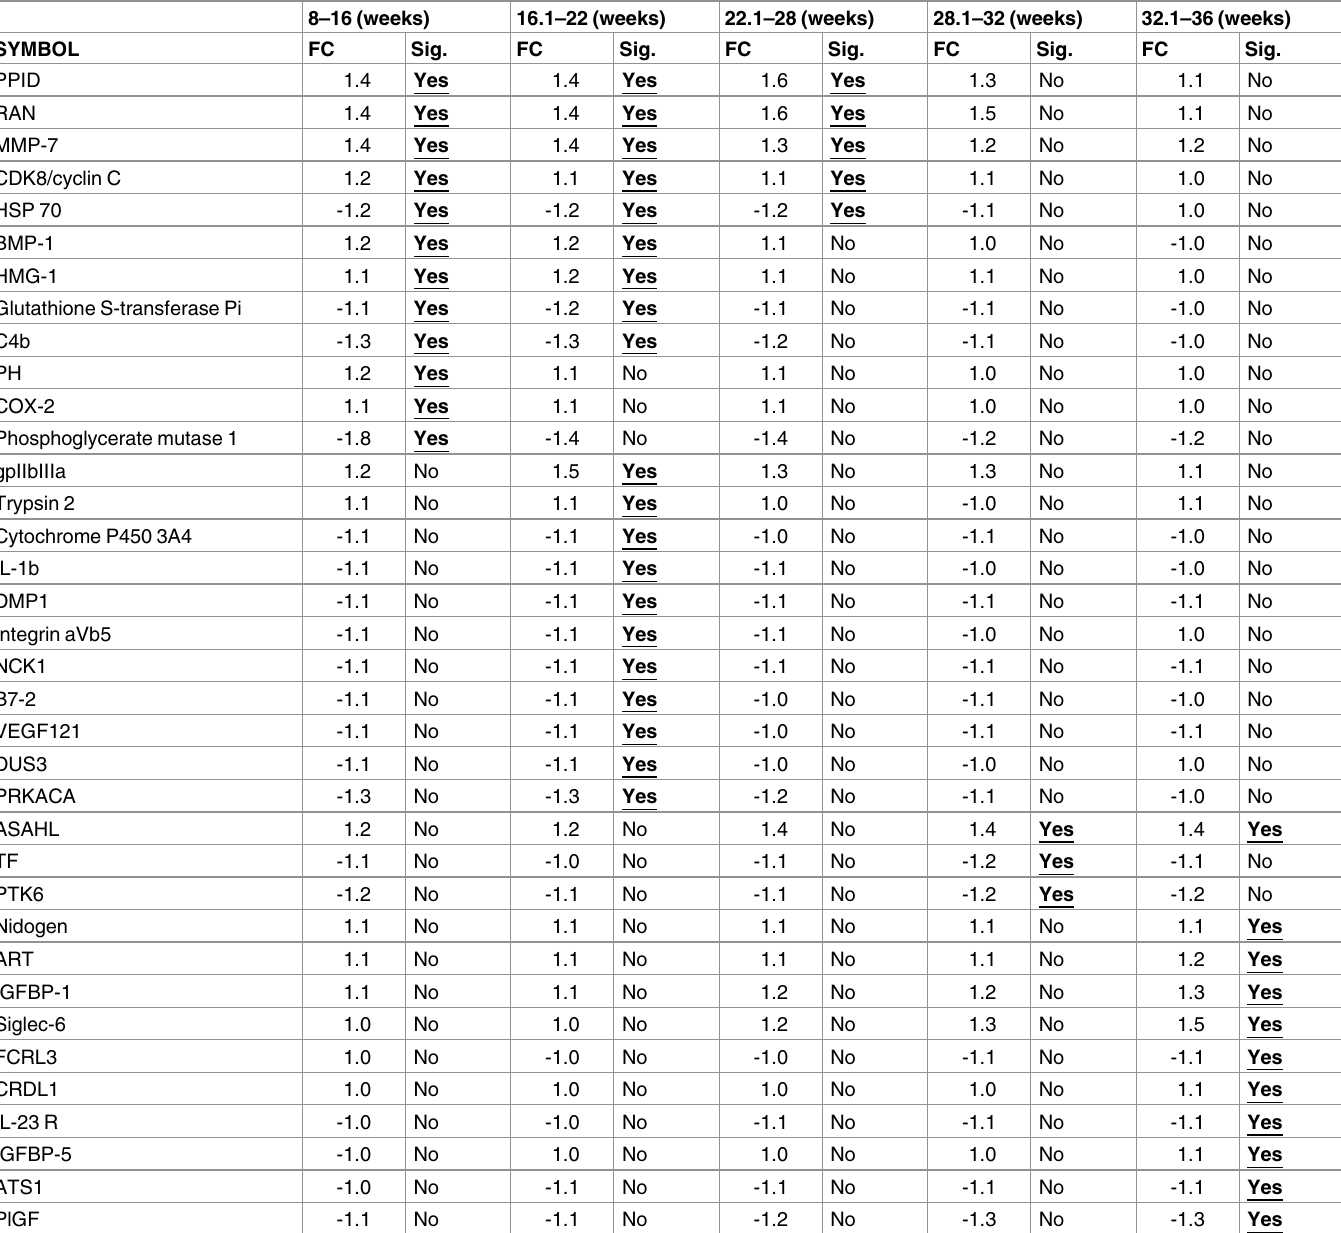
Table 4. Summaryof differential abundance analysis between late-onset preeclampsia and normal pregnancy in five intervals of